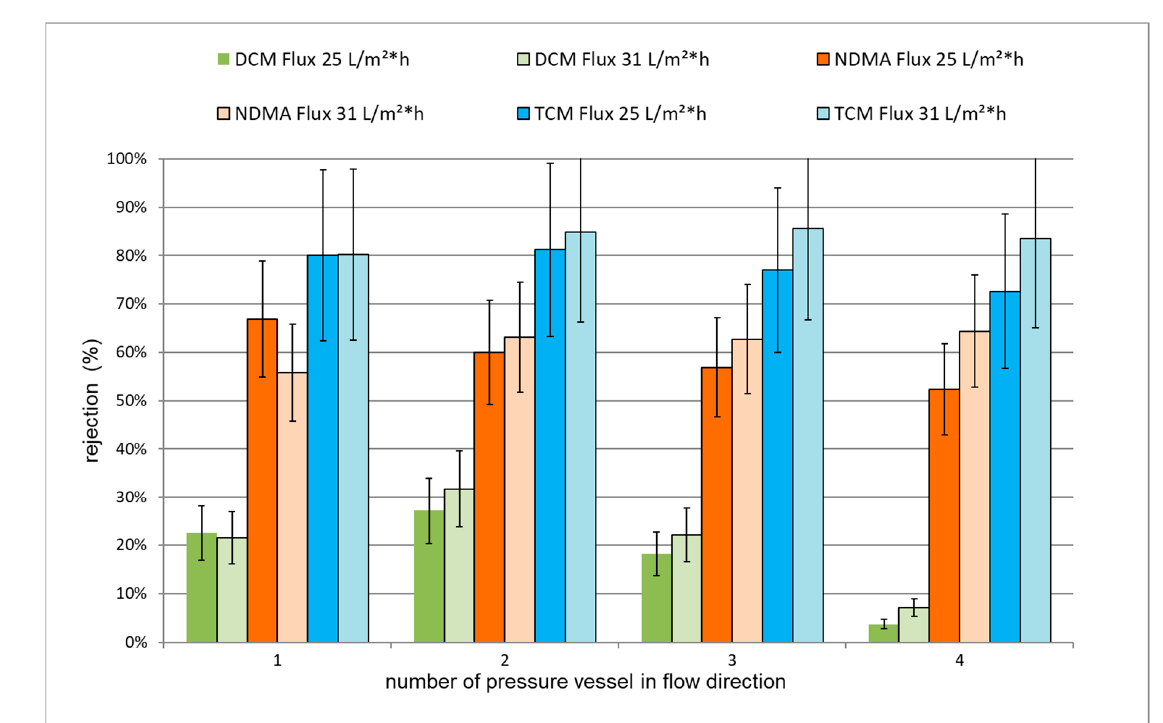
Figure 7. Apparent rejection for exemplary TrOCs at different fluxes for different pressure vessels with estimated errors.